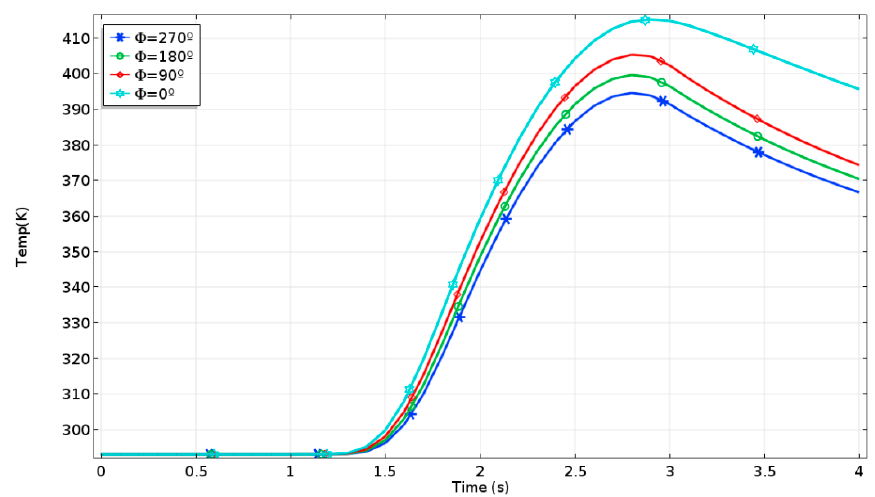
Figure 7. Circumferential temperature distribution of friction brake surface.